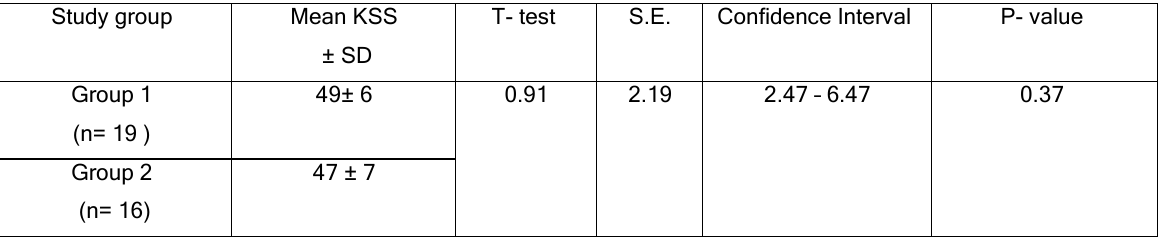
Table (7) shows the comparison between both groups in regard to KSS after one year of the operation. Non- Significant statistical analysis (P>0.05) was